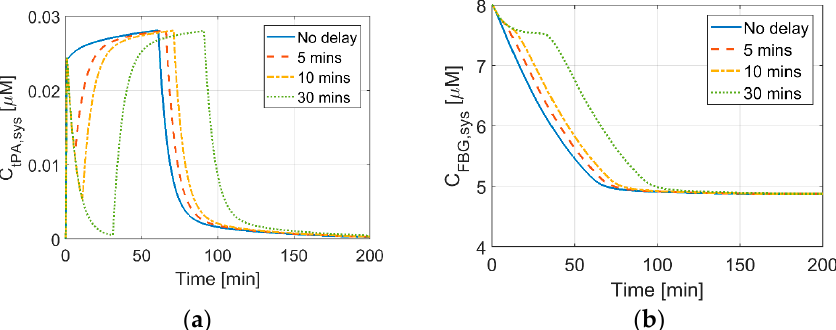
Figure 5. Effects of bolus-continuous IV infusion delay on the concentrations of ( a ) tPA and ( b ) FBG. Simulated Regimens 4–6 correspond to delays of 5, 10, and 30 min, respectively. The reference regimen with no delay (Regimen 1) is also included for comparison.